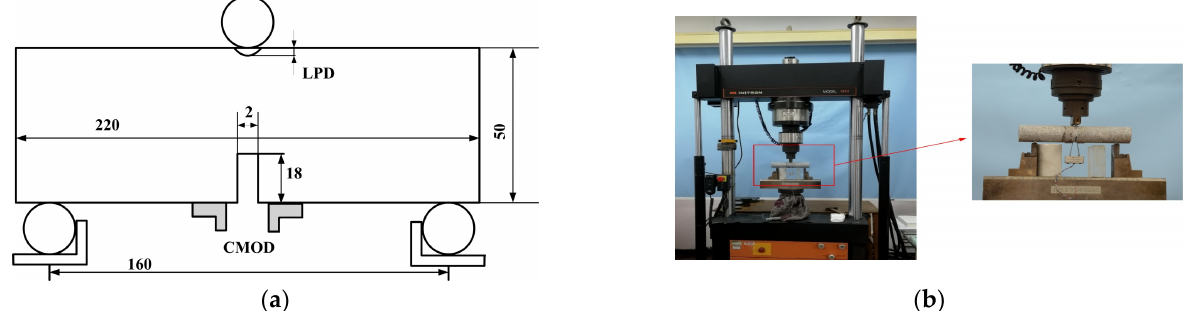
Figure 5. Three-point bending experiment information. ( a ) Schematic diagram; ( b ) Specific device.